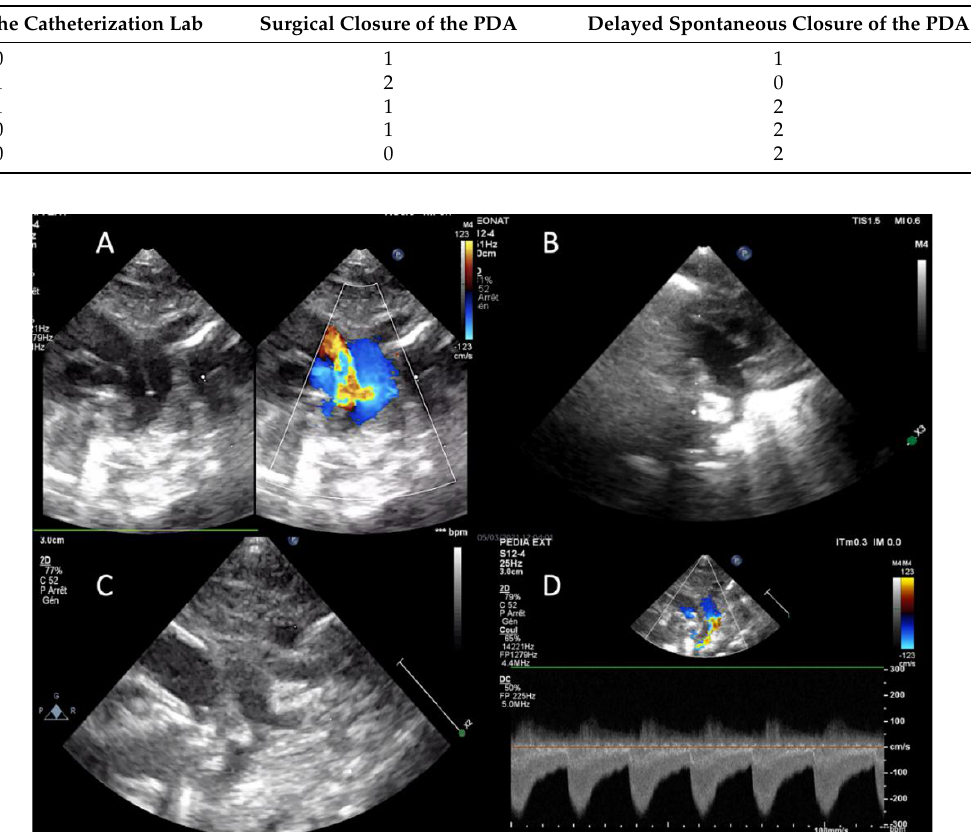
Table 3. Table representing the evolution of the stopped procedures over the years.